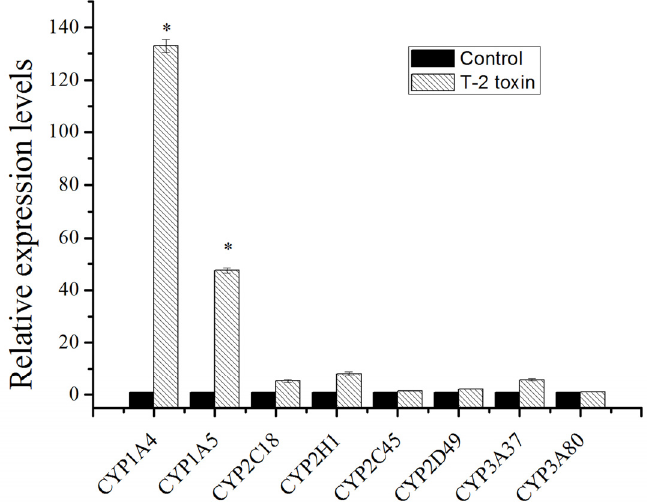
Figure 1. Quantitative real-time PCR of CYPs. Chicken embryonic hepatocyte cells were exposed to T-2 toxin at 0.1 μ g/mL for 48 h. The mRNA levels of CYP1A4 (Gene ID: 396052), CYP1A5 (Gene ID: 396051), CYP2C45 (Gene ID: 414833), CYP2C18 (Gene